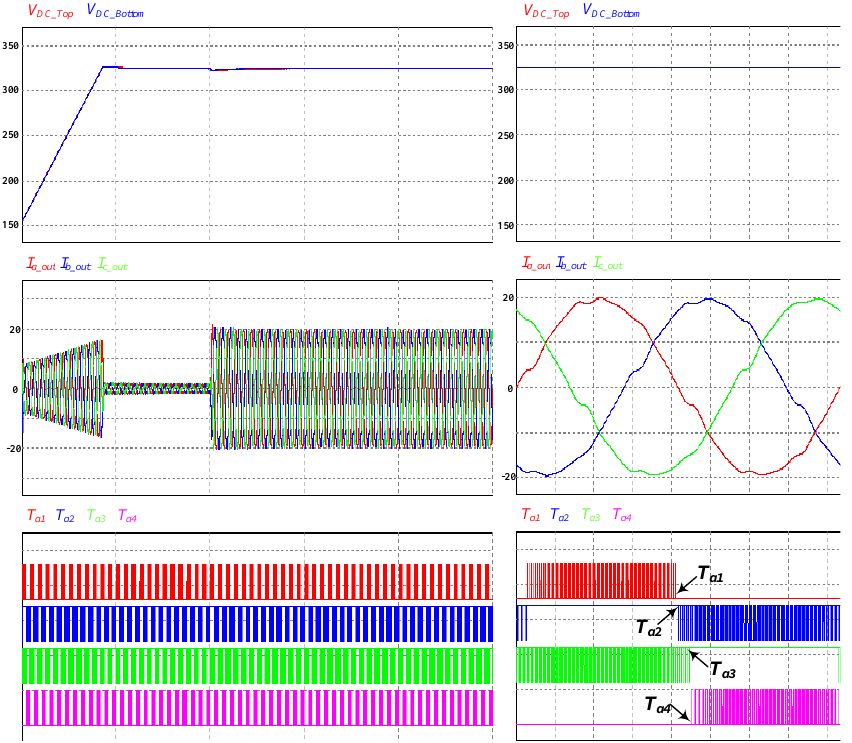
Figure 24. Simulation results using the dc-link balancing control applied in the SVPWM method.